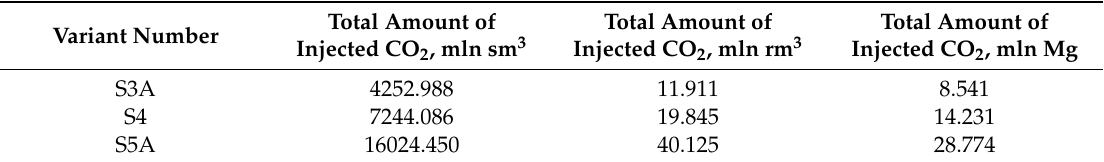
Table 9. List of the results obtained for the total amount of CO 2 injected in particular variants of the simulation in the D ę bowiec formation.